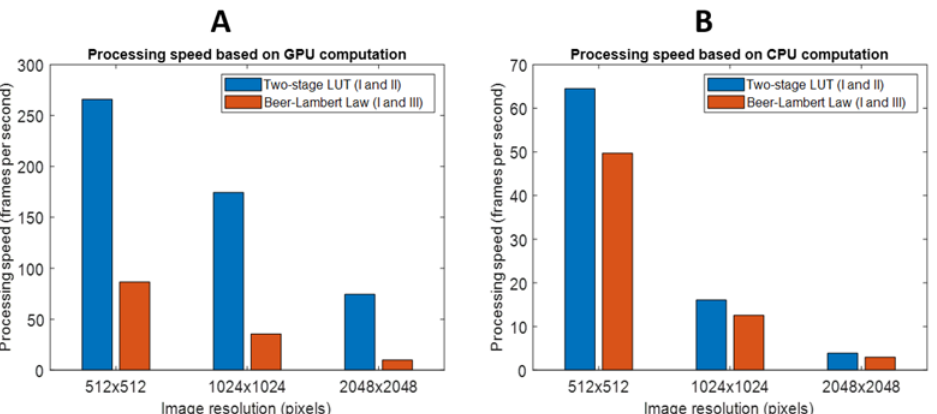
Figure 5. ( A ). Quantification frame rate of optical and perfusion properties of three image sizes with a GPU and a CPU. ( B ). Processing time increases as the image size increases for both GPU- and CPU-based processing. However, the GPU-based processing is less affected.